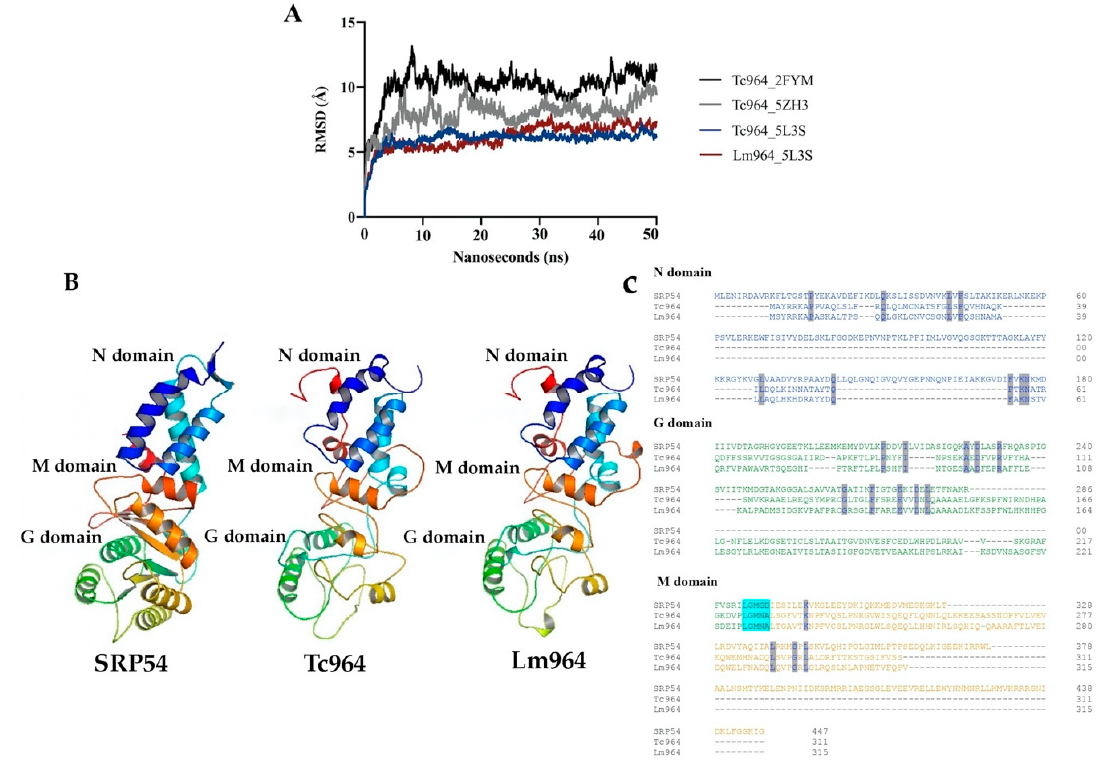
Figure 2. Molecular dynamics and structures of Tc964 and Lm964 proteins. ( A ) Root Mean Square Deviation values obtained during the 50 nanoseconds (2500 frames) of unrestricted molecular dynamics trajectories of the obtained models. Black line: Tc964_2FYM (template PDB code:2FYM) [38]. Gray line: Tc964_5ZH3 (template PDB code:5ZH3) [39]. Blue and red lines: Tc964_5L3S, Lm964_5L3S (template PDB code:5L3S) [37]. ( B ) Structural models of the 964 proteins from T. cruzi and L. major. Left: 3D Structure of the template SRP54 (PDB code:5L3S). Center: 3D structure model for Tc964 protein. Right: 3D structure model for Lm964 protein. N, G and M domains are located on the structures. 3D figures were generated using PyMOL Molecular Graphics System, (version 2.0, Schrödinger LLC, Portland, OR, USA) [43]. ( C ) Alignment between the sequence of SRP54 template protein and the 964 proteins of T. cruzi and L. major using the Omega Clustal program [44]. The domains N, G, and M are shown with the representative colors of the 3D model. Identical amino acids are highlighted in gray and the motif LGMGD is highlighted in alcian blue.